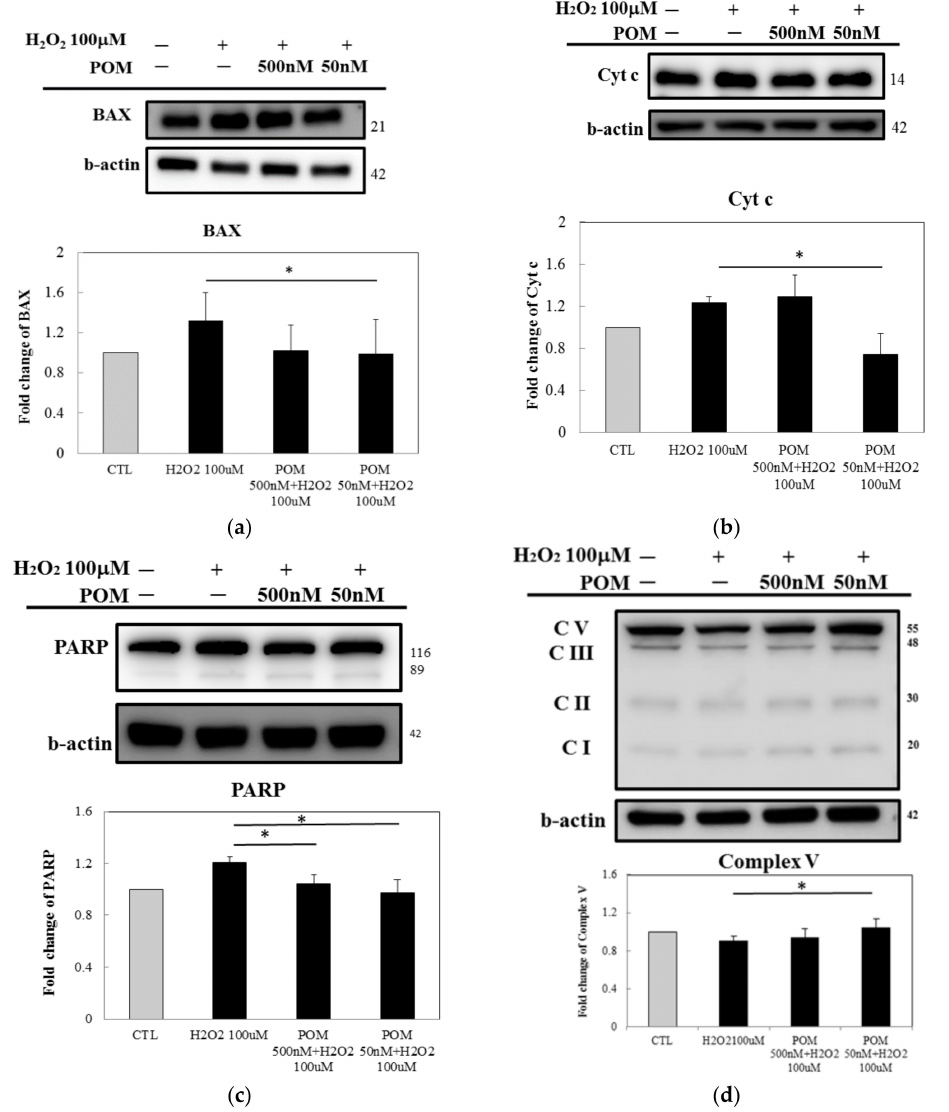
Figure 5. Pomalidomide (POM) decreases the expression of proteins within the mitochondrial Cytochrome c (Cyt c)-mediated apoptosis pathway and enhances the activity of mitochondria complex V. H 2 O 2 -induced cellular death raised protein levels of BAX, Cyt c and PARP within the apoptotic pathway ( p ≤ 0.05 for control (CTL) versus H 2 O 2 alone group). POM-pretreatment (particularly 50 nM) significantly inhibited the activation of the cell death; significantly inhibiting H 2 O 2 -induced BAX, Cyt c and PARP elevations (* p ≤ 0.05 versus 100 µ M H 2 O 2 -alone challenged